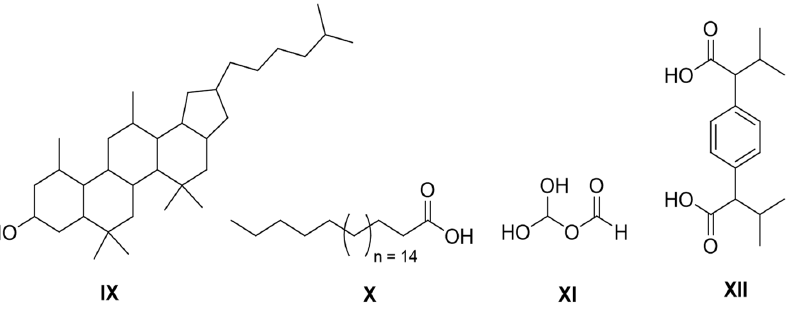
Figure 1. Structure of compounds IX–XII.